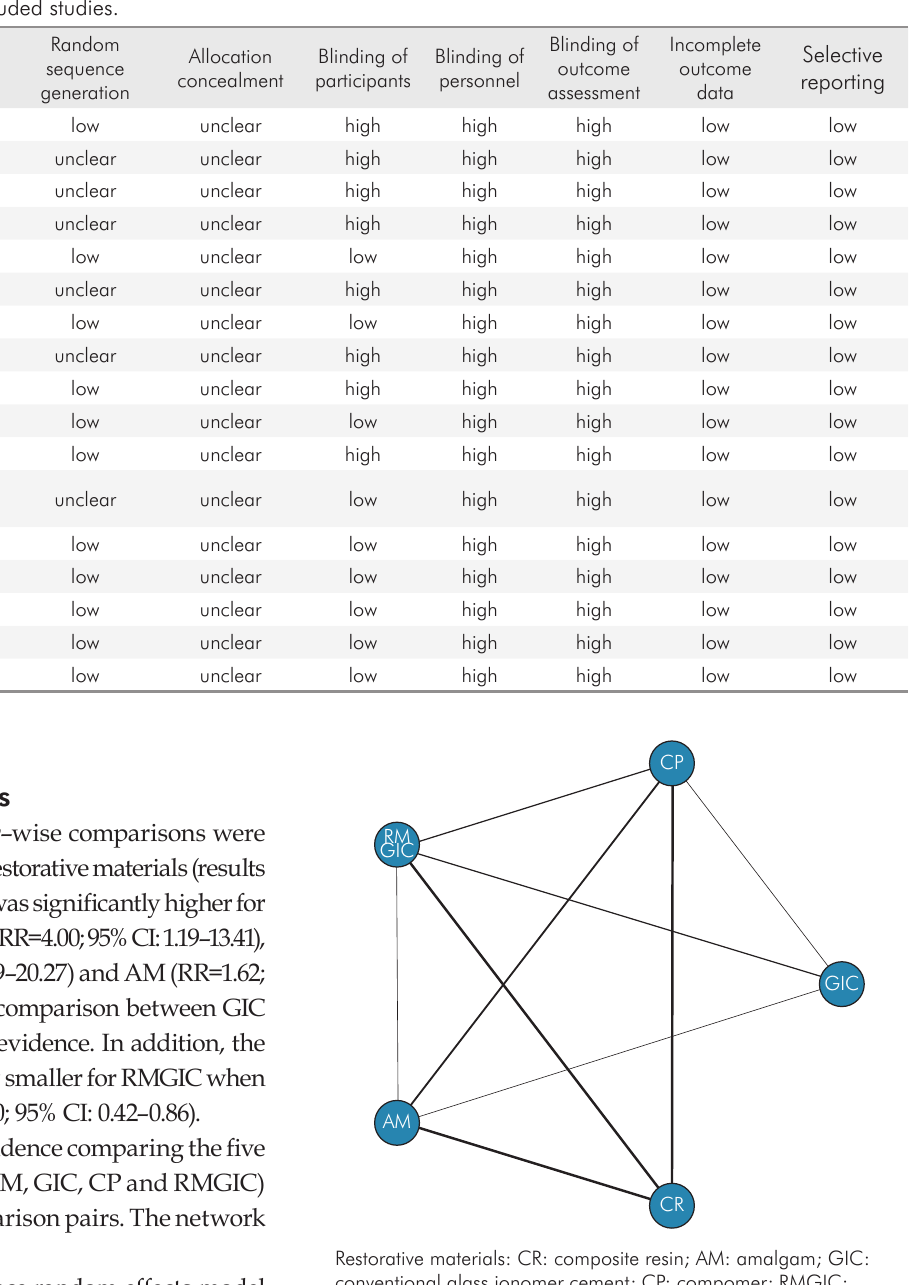
Figure 2. Comparisons network of conventional restorative materials placed in primary teeth. The width of lines connecting each pair of treatment is proportional to the number of trials comparing the treatments.